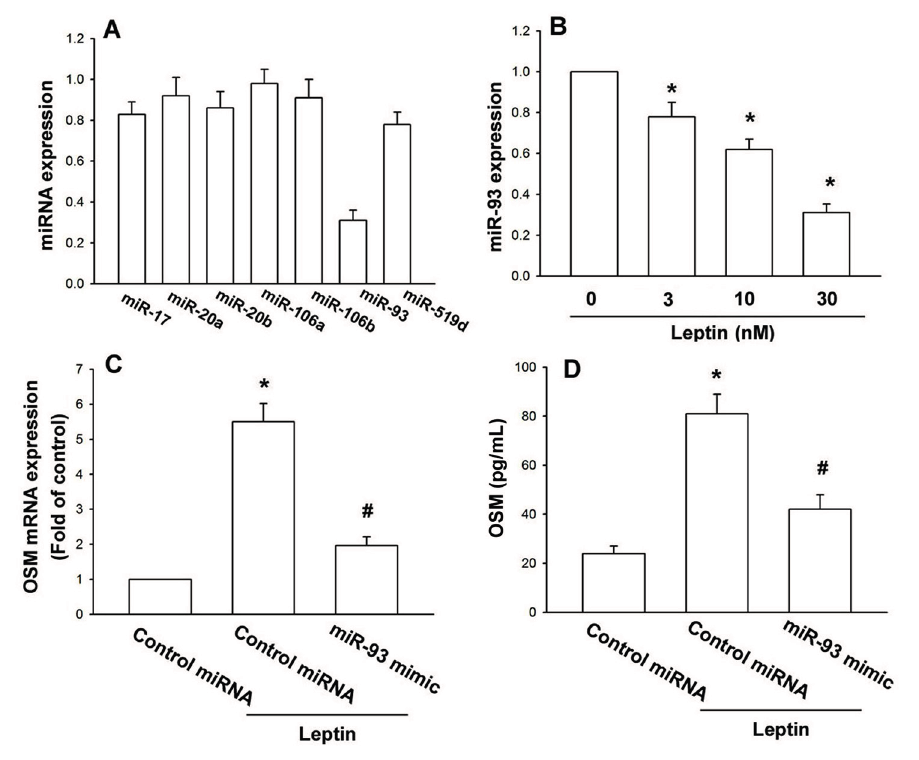
Figure 3. Leptin increases OSM expression through inhibition of miR-93 expression. ( A ) Osteoblasts were incubated with leptin (30 nM) for 24 h; the miRNAs’ expression was assessed by qPCR; ( B ) Osteoblasts were incubated with leptin for 24 h; miR-93’s expression was assessed by qPCR; ( C , D ) Osteoblasts were transfected with the miR-93 mimic for 24 h, followed by stimulation with leptin (30 nM) for 24 h; OSM expression was examined by the qPCR and ELISA assay ( n = 5). The results are expressed as the mean ± SEM; * p < 0.05 as compared with the basal level; # p < 0.05 as compared with the leptin-treated